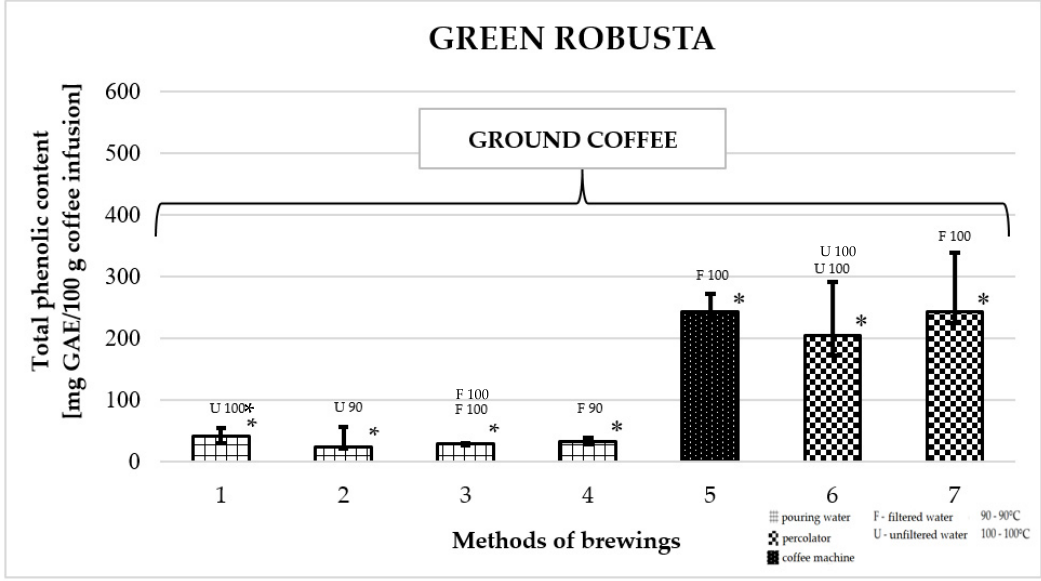
Figure 6. Total phenolic content as gallic acid equivalent [mg GAE / 100 g of infusion] in 100% green Robusta co ff ee. * p 1 / 5,6,7 ; * p 2 / 5,6,7 ; * p 3 / 5,6,7 ; * p 4 / 5,6,7 ; * p 5 / 1,2,3,4 ; * p 6 / 1,2,3,4 ; * p 7 / 1,2,3,4 —statistically significant di ff erences (* p < 0.05). Preparation of the infusion: 1: pouring water, 100 ◦ C,